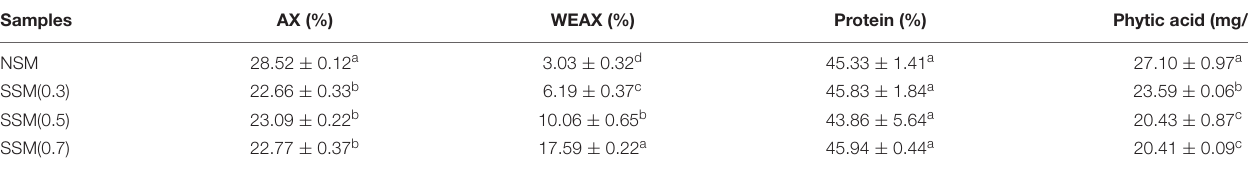
TABLE 1 | Chemical composition of soybean meal powder. Samples